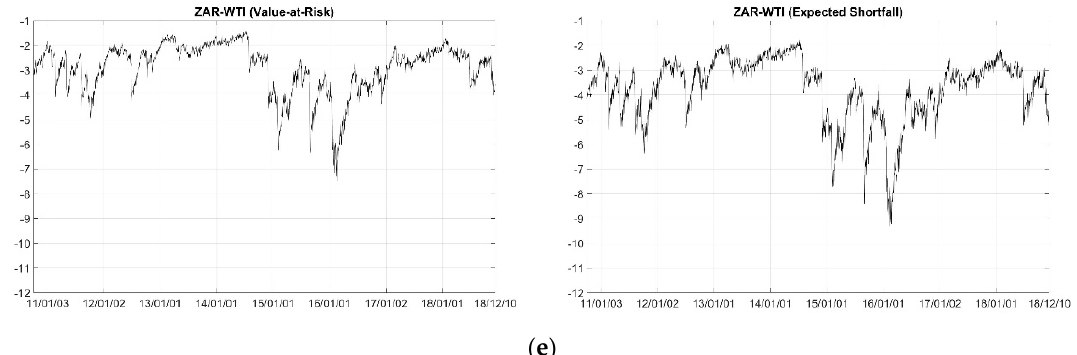
Figure 4. Conditional 1% Value at Risk (left panel) and Expected Shortfall (right panel) for an equal-weighted portfolio based on the Student’s t copula model. ( a – e ) refer to BRL–WTI, RUB–WTI, INR–WTI, CNY–WTI and ZAR–WTI pairs, respectively.